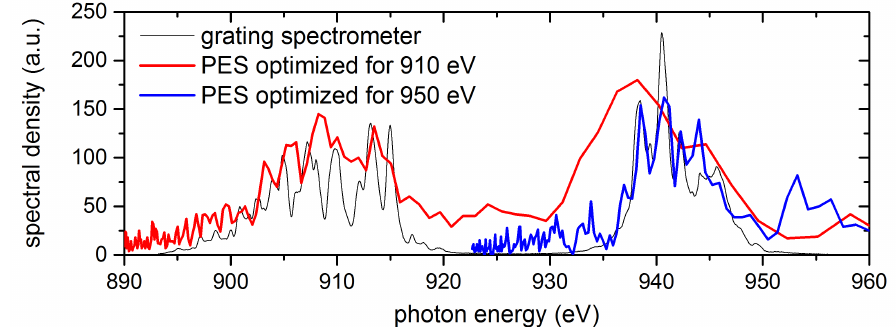
Figure 13. Single shot spectra measured with grating spectrometer (black line), with PES optimized for 910 eV emitted in U2 (red line) and with PES optimized for 950 eV emitted in U1 (blue line). An average pulse energy was about 600 µ J in each